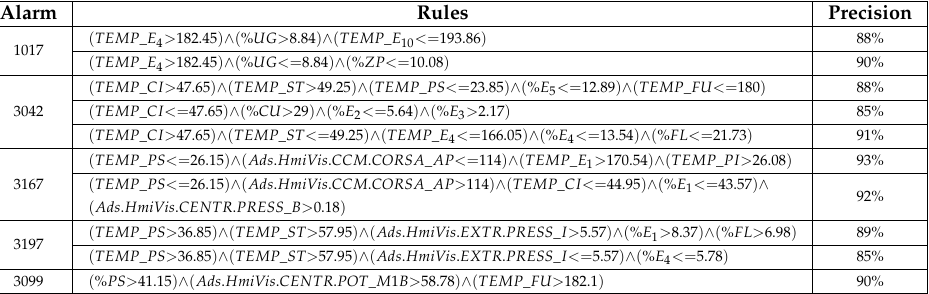
Table 5. Decision Tree (DT) based rule learner (RUL = 60 s).